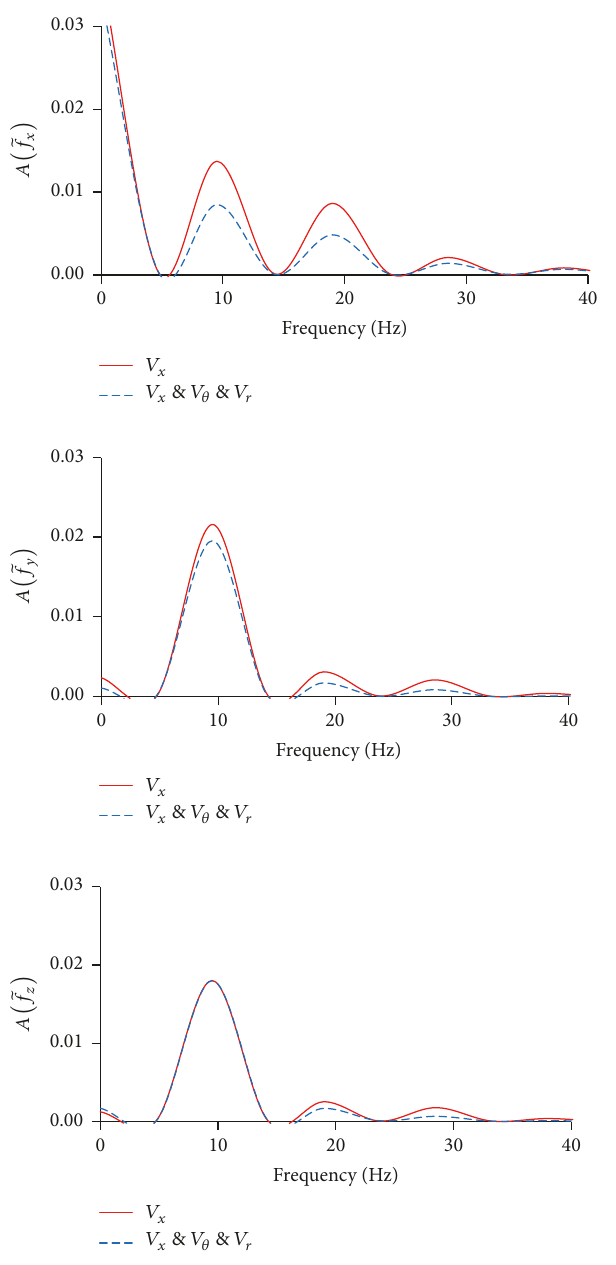
Figure 25: Influence of cross flows on harmonics of exciting forces of one blade. Figure 26: Influence of cross flows on the exciting forces of the whole